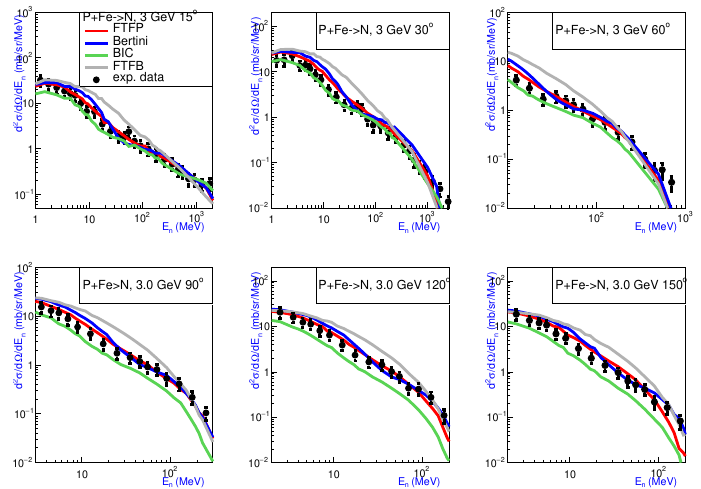
Figure 2. Inclusive cross sections of neutrons produced in p + Fe interactions at projectile momentum 3 GeV / c at various emission angles of neutrons. Points are experimental data [4]. Lines are calculations by the FTFP, FTFB, Bertini and Binary cascade